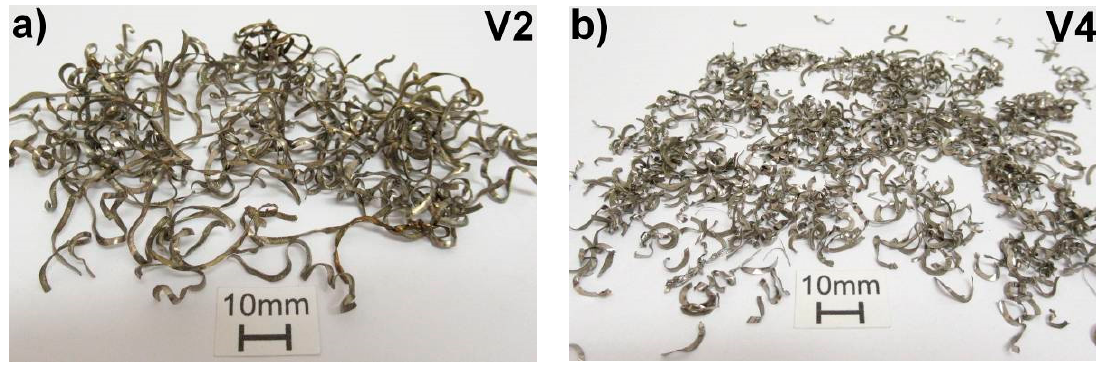
Figure 2. Macroscopic images of titanium Gr4 chips manufactured by machining: ( a ) coarse chips obtained by turning— variant V2, ( b ) coarse chips obtained by milling—variant V4.